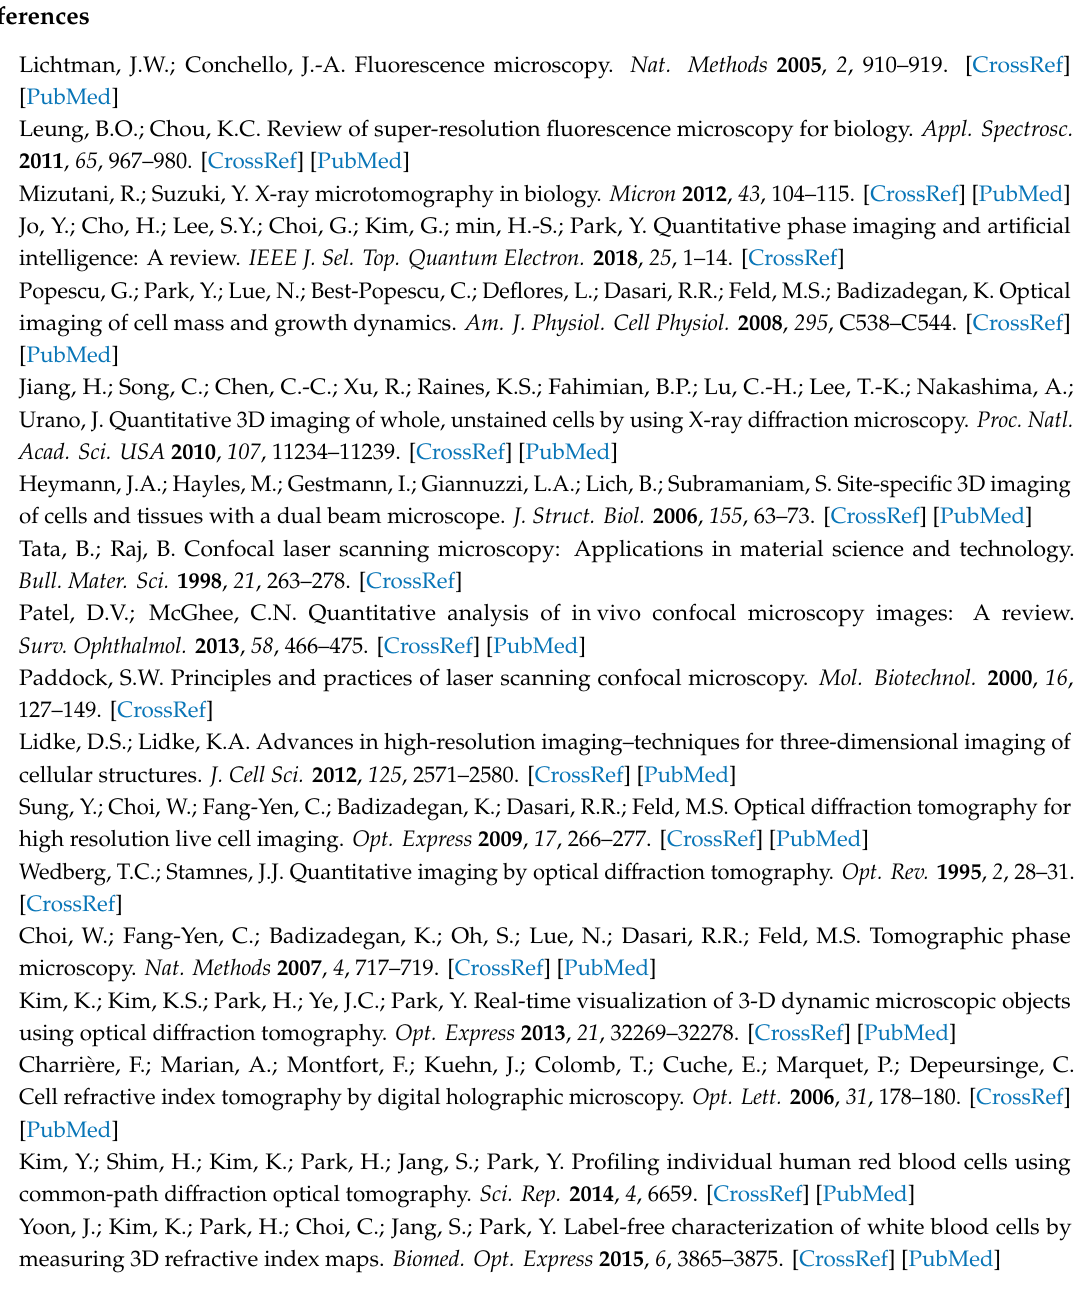
Figure S1: Intensity contours and intensity profiles in top-view and side-view of fluorescent beads. Figure S2: Fabrication steps of the micromirror-embedded coverslip with a stage for imaging of red blood cells. Video S1: Real-time measurement of a green fluorescent bead using micromirror-embedded coverslip